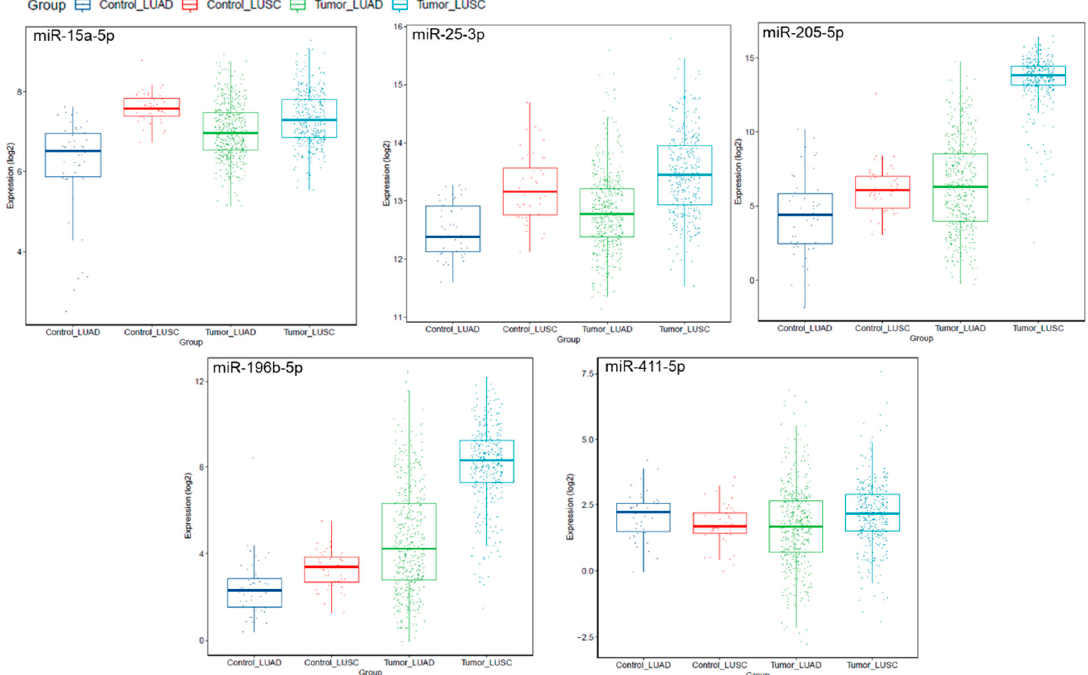
Figure 4. Expression levels of miRNAs miR-15a-5p, miR-25-3p, miR-205-5p, miR-196b-5p and miR- 411-5p in lung adenocarcinoma (LUAD; n = 561) and lung squamous cell carcinoma (LUSC; n = 523), compared to normal lung tissues (control LUAD, n = 46; control LUSC, n = 45; TCGA dataset). This analysis shows miRNA expression levels by histological subtype, for better data visualization, since the TCGA data includes large sample sets.